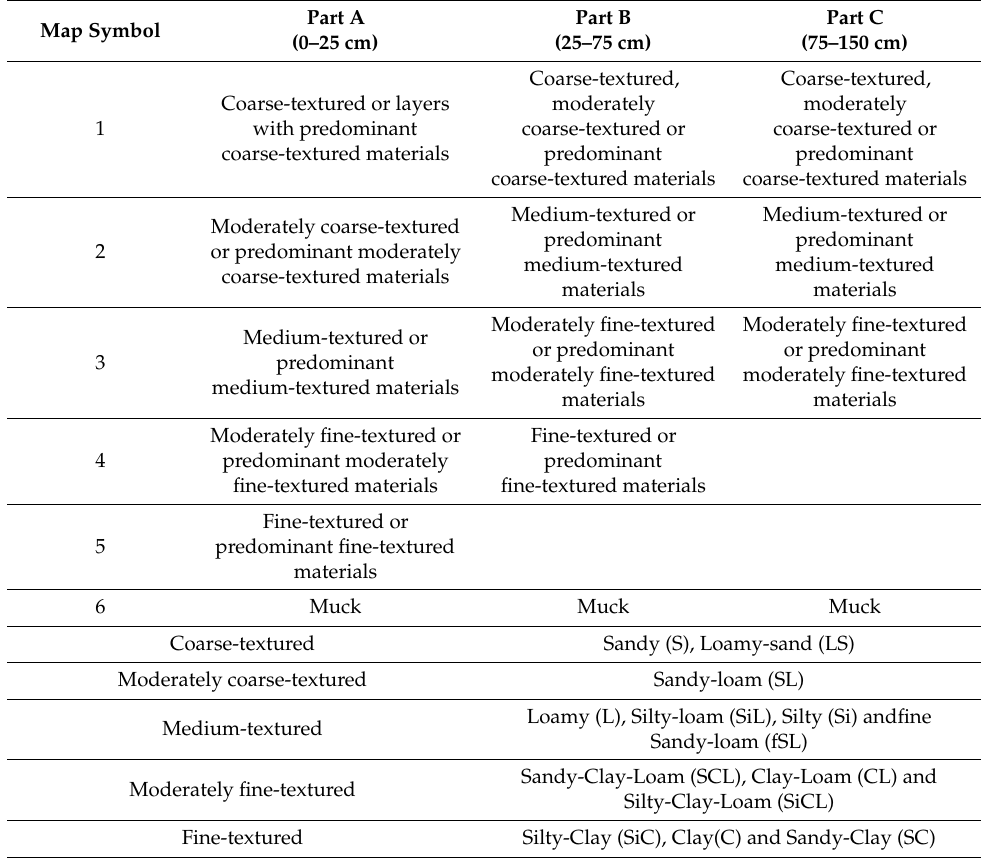
Table A2. Classes of soil texture with the corresponding symbols for the three parts of soil profile.